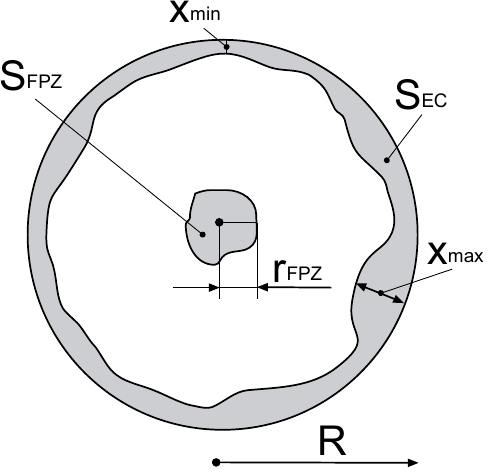
Figure 11. Scheme of the parameters used for defining the fracture surfaces in the quantitative fractographic analysis.